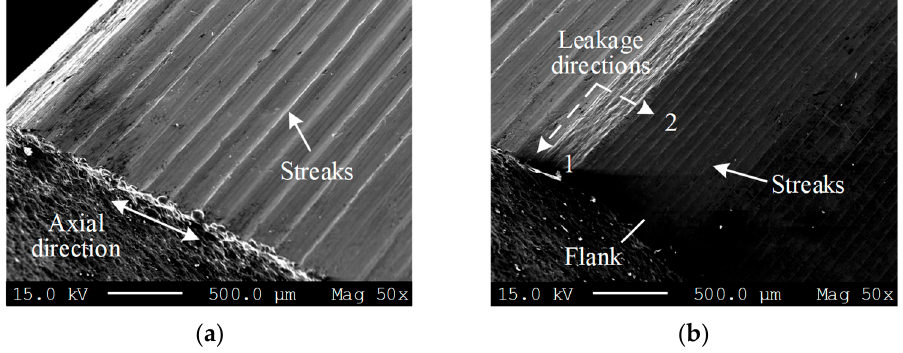
Figure 6. Observation of ridge surfaces with SEM: ( a ) sealing surface and ( b ) flank surface.